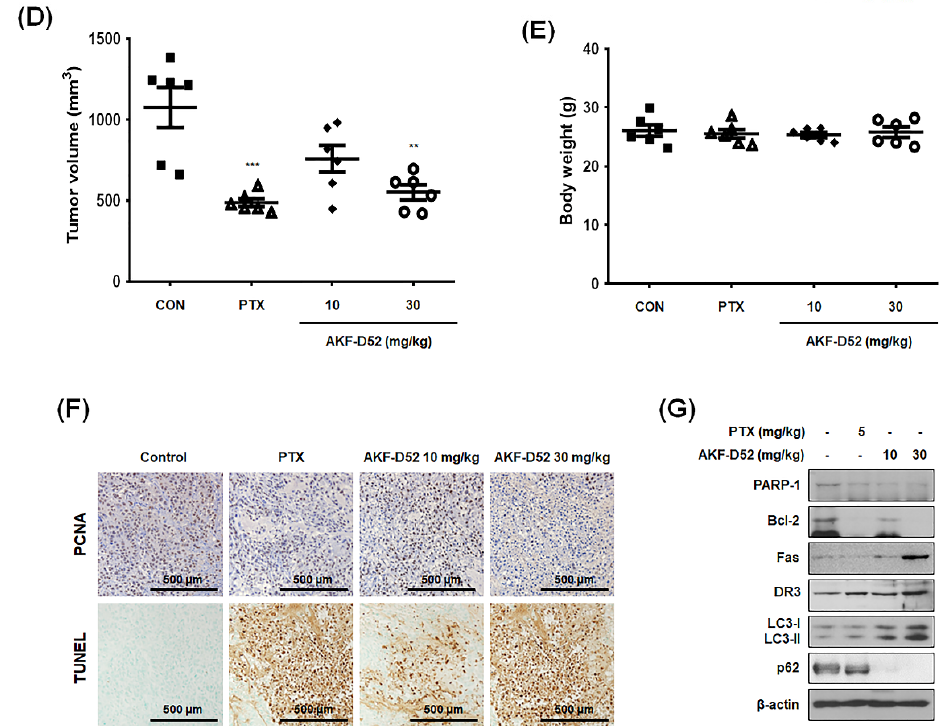
Figure 7. Antitumor activity of AKF-D52 in an A549 xenograft mouse model. ( A ) The scheme of the in vivo experiment. ( B ) Tumor volumes (mm 3 ) were measured twice a week during the experimental period. ( C , D ) After sacrifice, tumors were separated from the mice, and tumor weight or volume were measured. ( E ) Body weights were measured prior to sacrifice. ( F ) The expression of PCNA was evaluated by IHC analysis, and the induction of apoptosis was examined based on a TUNEL assay using tumor sections. ( G ) Isolated tumor tissues were homogenized, and Western blot analysis was performed, as described in the Materials and Methods section. β -actin was used as an internal control. Data are presented as the means ± SD of values from measurement ( n = 6), and significant differences are denoted as * p < 0.05, ** p < 0.01, *** p < 0.001 vs. the vehicle-treated group.